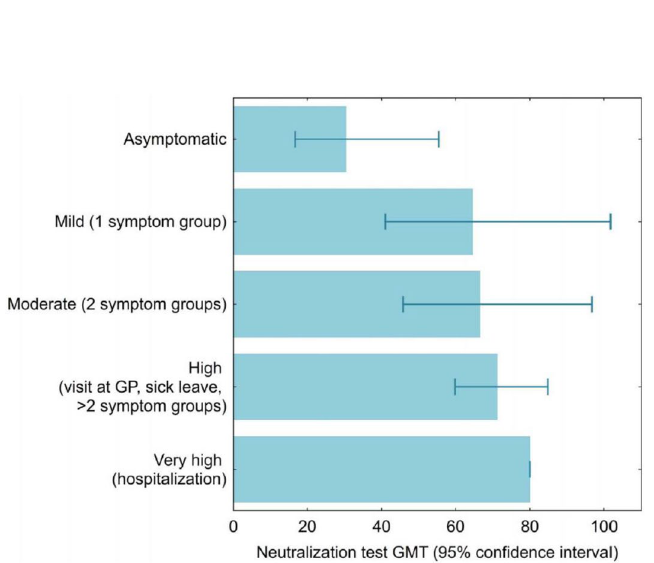
Figure 3. The severity of symptoms related to neutralization titer. GMT geometric mean titer, GP general